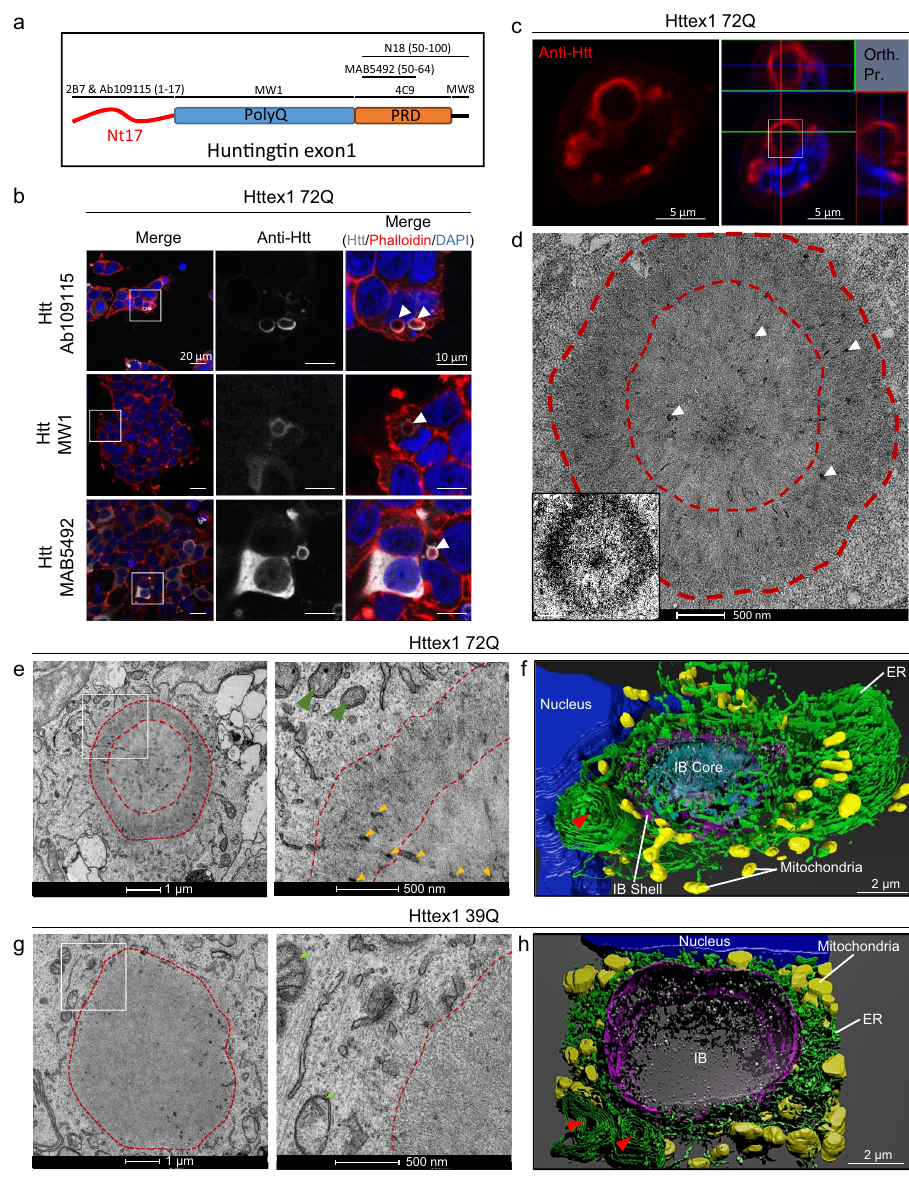
Fig. 1 Confocal microscopy and CLEM revealed the ring-like structure of the Httex1 72Q inclusions in HEK cells. a Epitope mapping of the Httex1 antibodies used in this study. b Confocal imaging of Httex1 72Q inclusions formed 48 h after transfection in HEK cells. All the Htt antibodies showed strong immunoreactivity to the periphery of the inclusions. The nucleus was counterstained with DAPI and the F-actin with phalloidin. White arrows indicate the colocalization of the F-actin with the ring-like structure of Httex1 inclusions. Scale bar = 20 μ m and 10 μ m. c , d CLEM of Httex1 72Q inclusions. c Confocal imaging of Httex1 72Q inclusions formed 48 h after transfection in HEK cells. The selected area (white square) was examined by EM ( d ). Orthogonal projection (Orth. Pr.), Scale bars = 5 μ m. d The presence of membrane fragments and vesicles are indicated by the white arrowheads. The binary image (inset) shows the core and the shell ultrastructure of the Httex1 72Q inclusion. Scale bar = 500 nm. e Representative EM images of Httex1 72Q inclusion. Higher magni fi cation (white square) are shown in the right panel. Dashed lines delimit the aggregate and the core of the inclusion. Internalized membranous structures and the mitochondria are indicated by the orange and the green arrowheads, respectively. Scale bar = 1 μ m and 500 nm. f 3D model of Httex1 72Q cellular inclusion and surrounding organelles (top view). The Httex1 inclusion body (IB) shell is represented in purple, the core in cyan. ER membranes are shown in green, intra-inclusion membranous structures in white, the nucleus in blue, mitochondria in yellow, and the stacked ER cisternae are indicated by a red arrowhead. Scale bar = 2 μ m. g Representative EM images of Httex1 39Q inclusion formed 48 h after transfection in HEK cells. The white square indicates the area shown in the right panel at higher magni fi cation. Dashed lines delimit the inclusion. Scale bar = 1 μ m and 500 nm. h 3D model of the Httex1 39Q IB is shown in purple, surrounded by mitochondria (yellow), ER structures (green), stacked ER cisternae (red arrowheads), intra-inclusion membranous structures are shown in white and the nucleus in blue. Scale bar = 2 μ